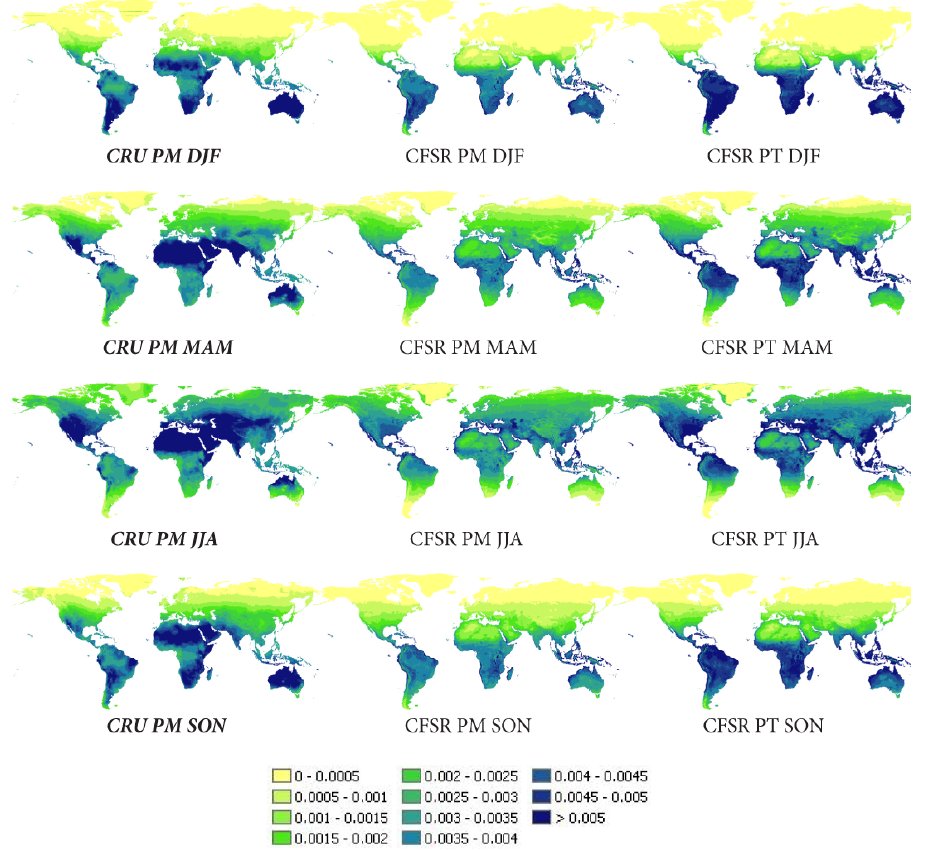
Fig. 4a. Global maps with seasonal average daily potential evaporation (mday − 1 ) . CRU derived with the Penman-Monteith equation (left; =reference for validation), CFSR derived with the Penman-Monteith equation (middle; PM) and CFSR derived with the Priestley-Taylor equation (right; PT). From top to bottom the DJF, MAM, JJA and SON seasons.